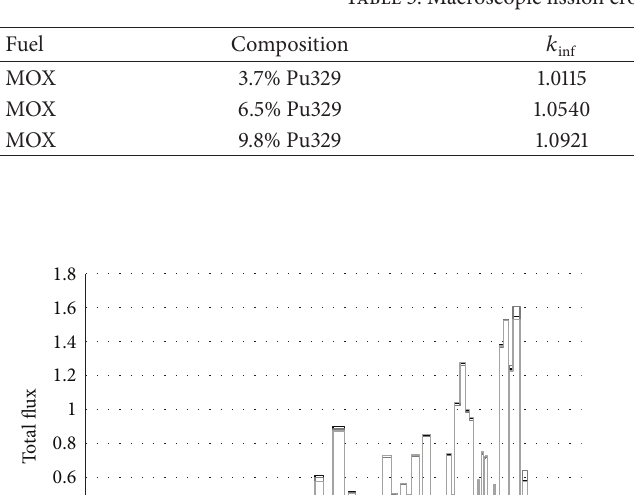
Figure 8: The plot of inelastic cross-section of 238 U as a function of energy. Table 5: Macroscopic fission cross-sections in MOX fuel cells.